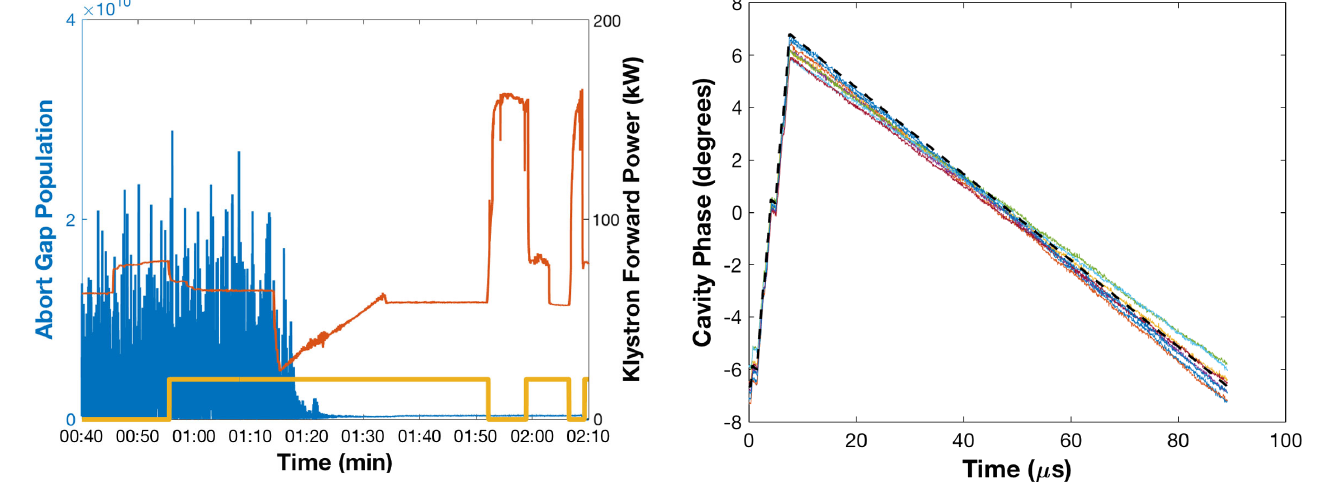
FIG. 16. Phase modulation for all cavities. 204 bunches, beam 1.